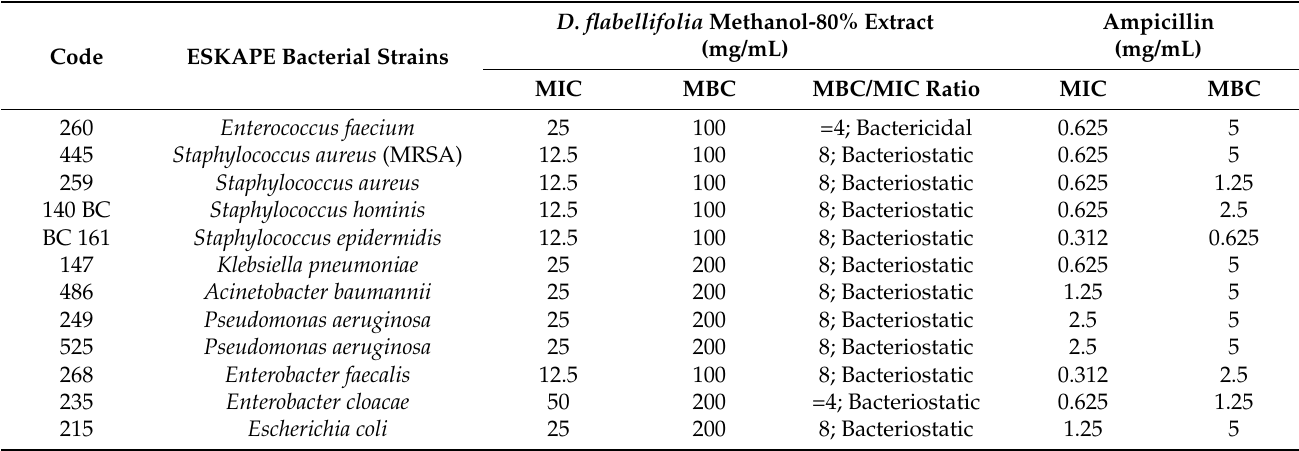
Table 3. Determination of MICs, MBCs, and MBC/MIC ratio values for ESKAPE strains as compared to known drugs.